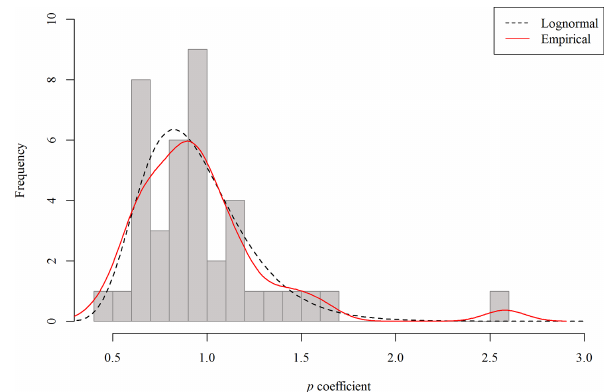
Figure 4. Distribution of morphometry ( p ) coefficients (full model) for all beaver ponds sampled ( n = 40).